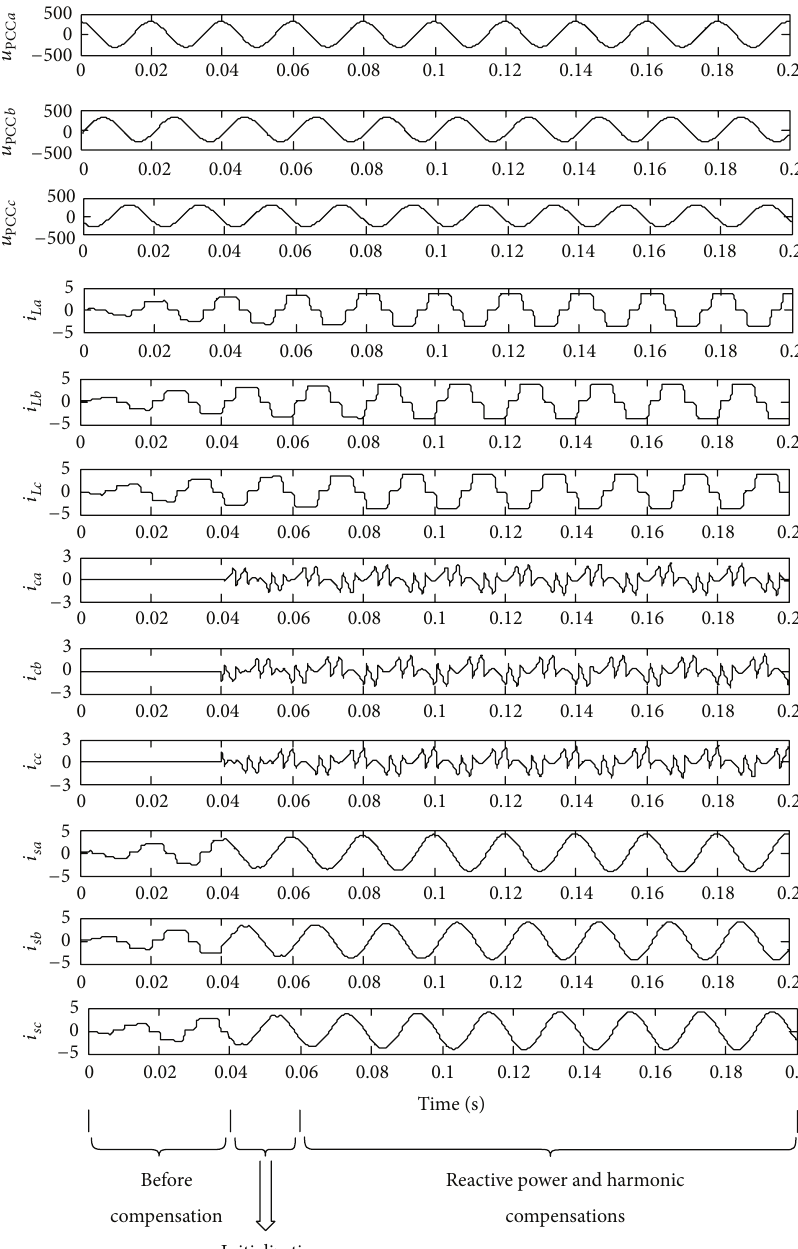
Figure 5: The simulation results using PQF algorithm for ideal shunt active power filter with balanced system.